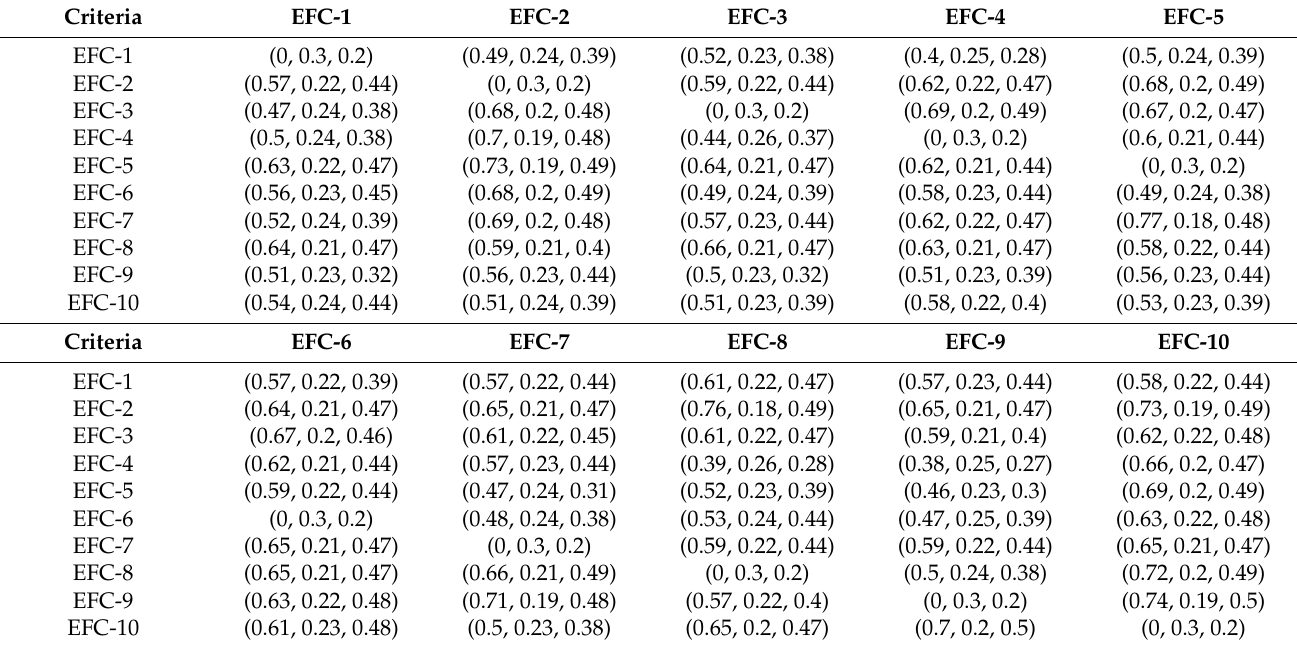
Table A4. The SF direct-influence matrix.